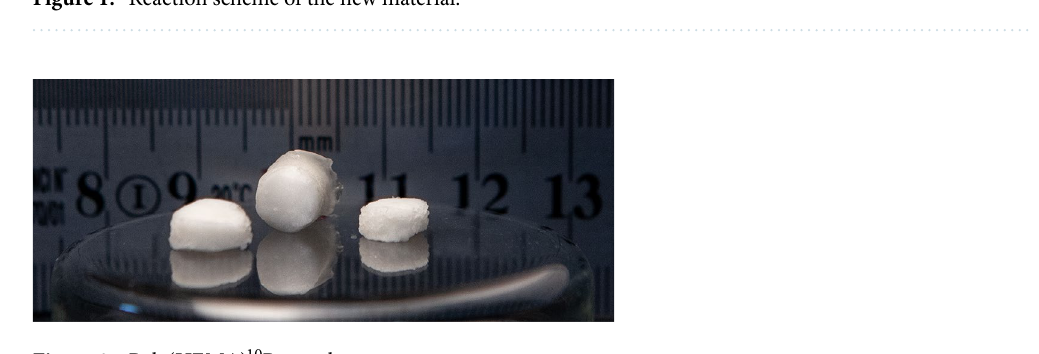
Figure 2. Poly(HEMA)